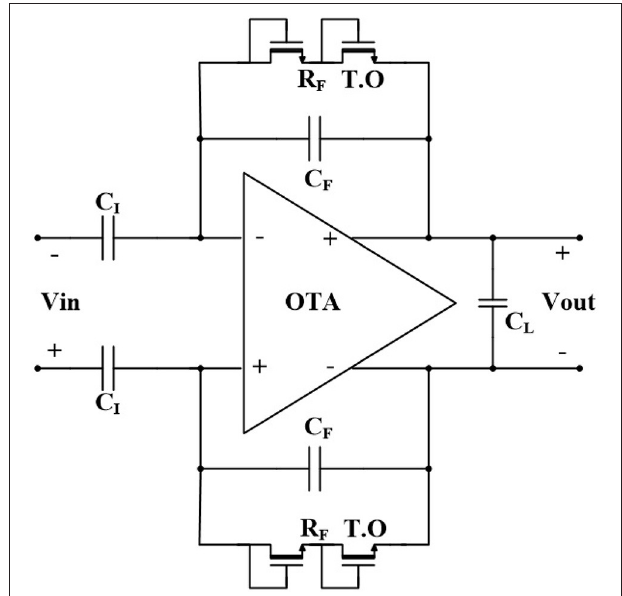
FIGURE 1 | Fully differential capacitive feedback network neural amplifier.